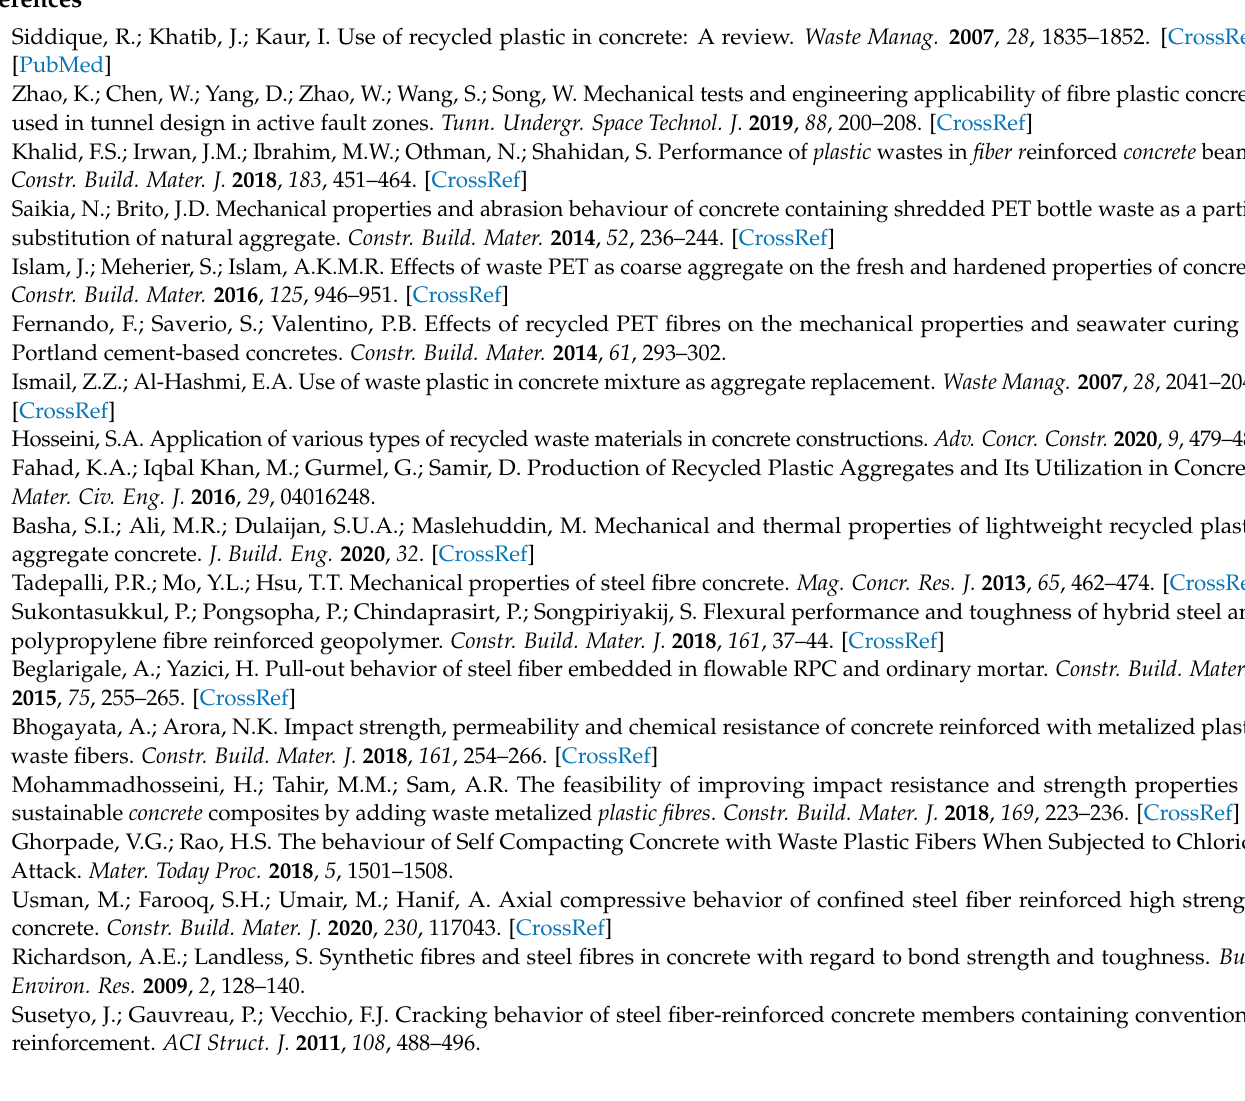
(f) The optimal plastic fiber volume (0.10% V f ) is promising in contributing to the fiber reinforcing efficiency in the matrix and crack bridging mechanism, providing maxi- mum stress carrying capacity. Maximum flexural strength (5.26 N/mm 2 ) and post peak drop load resistance (96%) were obtained in the tension zone confined concrete compared to full depth homogenous fiber reinforced